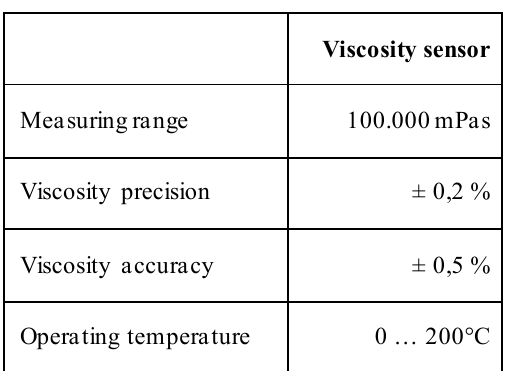
Table 1. Viscosity sensor key